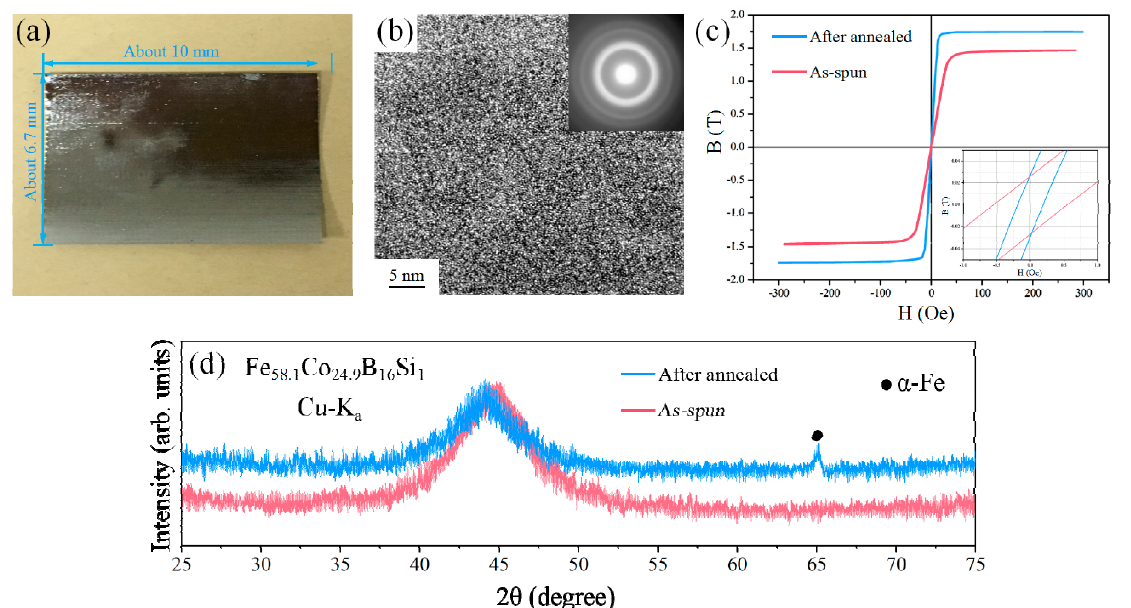
Figure 1. ( a ) Photograph of the fabricated Fe–Co–B ribbon; ( b ) transmission electron microscopy (TEM), high-resolution transmission electron microscopy (HRTEM) image of the Fe–Co–B alloy ribbon; the selected area electron diffraction (SAED) pattern is shown in the inset; ( c ) magnetizing force vs. magnetic flux density (H–B) hysteresis loops for the Fe–Co–B alloy ribbon in the as-spun and annealed (595 K, 1 h) states, the inset shows the partial enlargement for − 1~1 Oe; ( d ) XRD pattern of the melt-spun and annealed Fe–Co–B alloy ribbon.